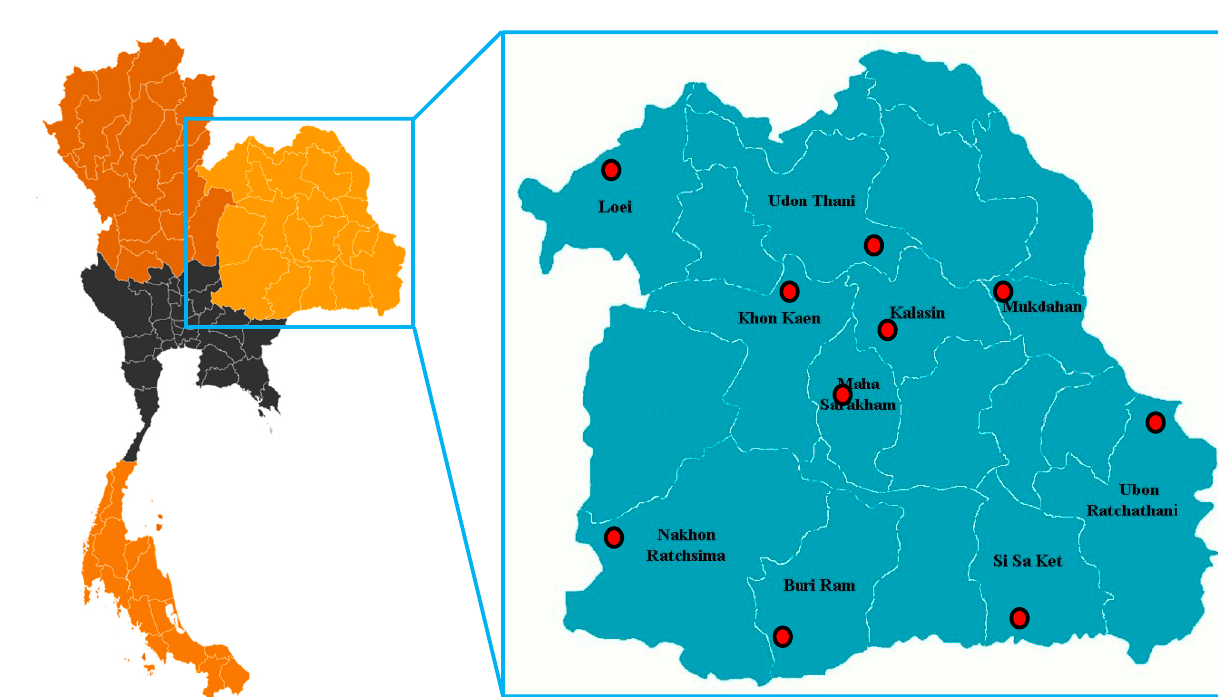
Figure 1. Location of selected study sites in northeast Thailand.